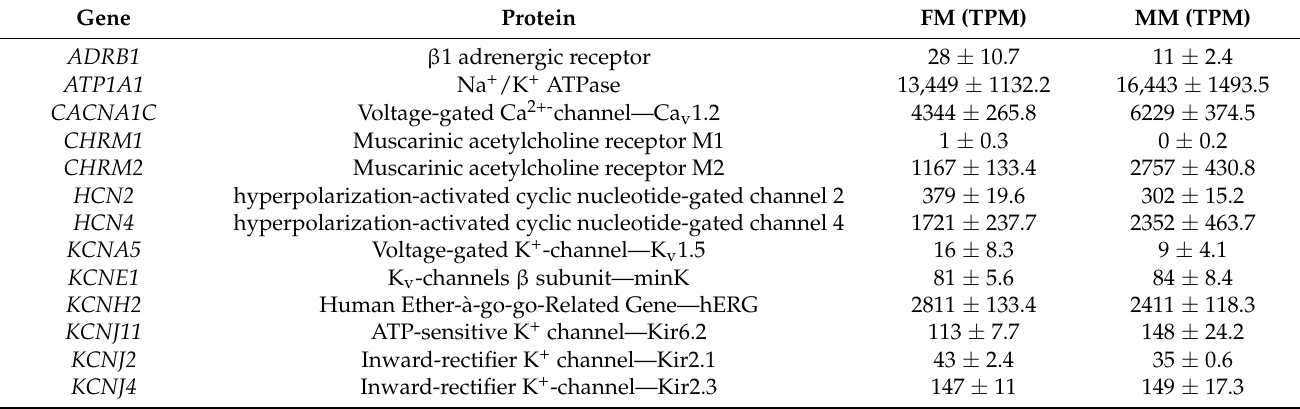
Figure 8. Gene expression principal component analysis of the two models. The first principal component (Comp.1) clearly shows a high degree of variability between two 2D monolayers of fibronectin (FM) (blue) and a 2D monolayer of Matrix Plus (MM) (green). Table 3. Gene expression of key cardiac ion channels and receptors in cells cultured on fibronectin (FM) and Cellvo™ Maturity Matrix (MM). The data are expressed as mean ± SEM transcripts per million (TPM).